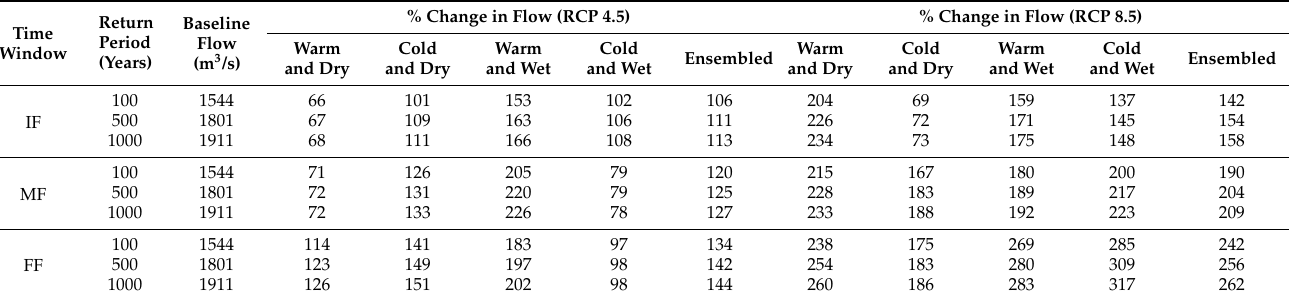
Table 3. One-day-maximum flood frequency analysis.